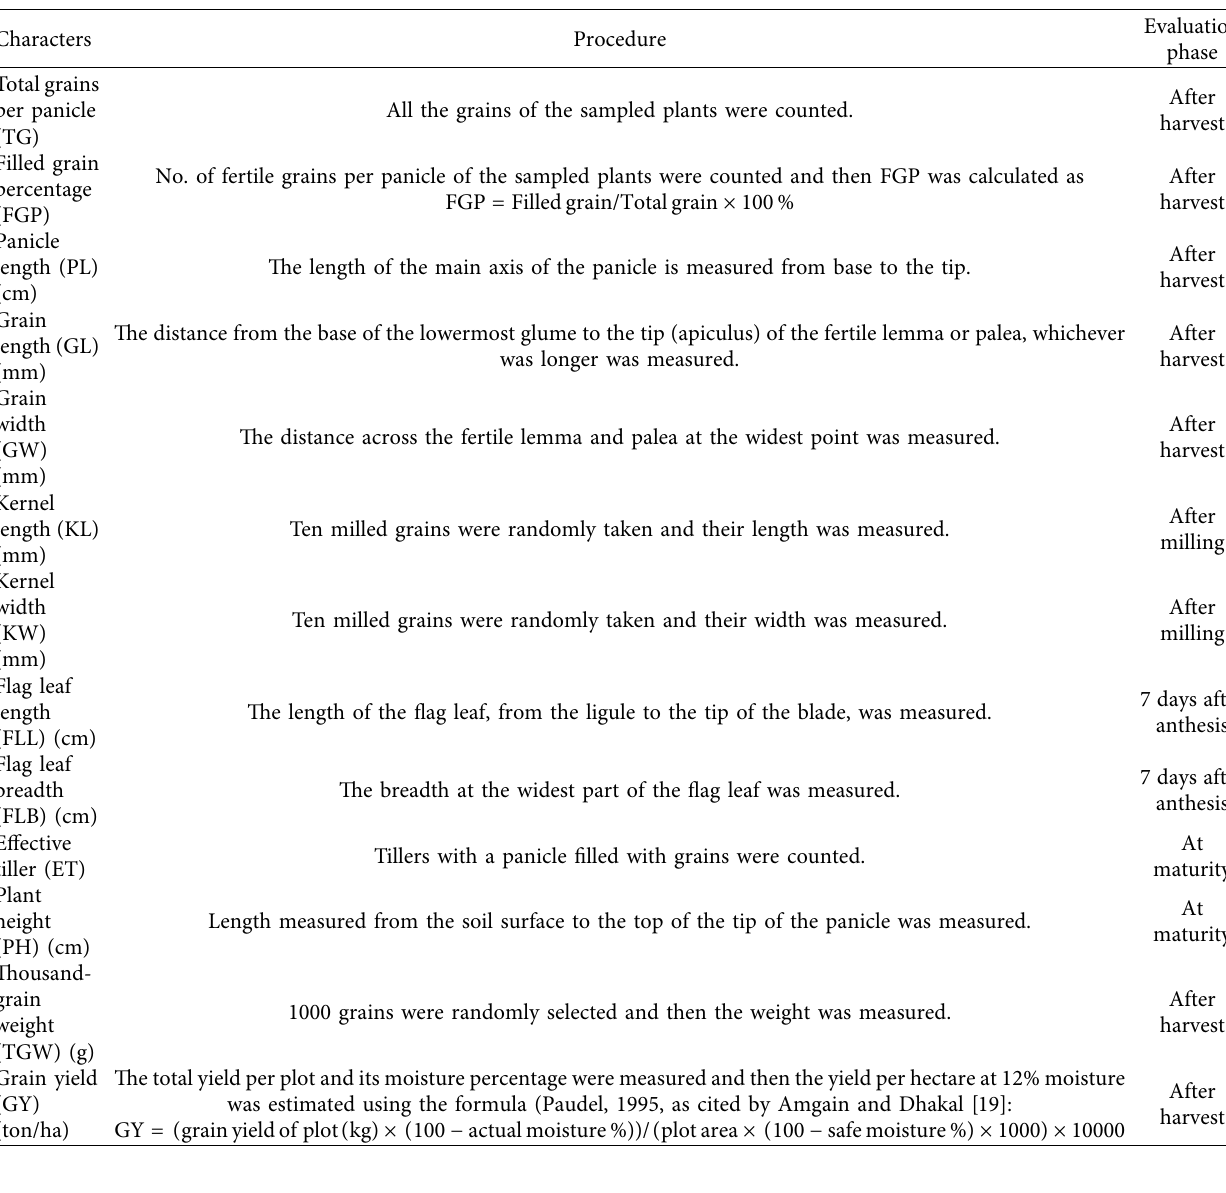
Table 2: Quantitative characters along with the procedure and evaluation